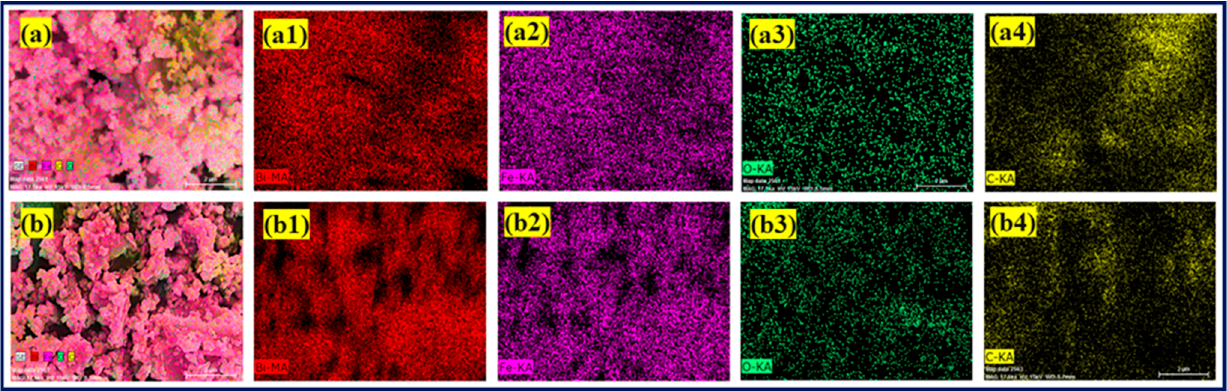
Figure 3. The energy dispersive X-ray spectroscopy image of [BiFe 1 − x Li x O 3 ]-graphene nanocompo- site. ( a – a4 ) x = 0.04 and ( b – b4 ) x = 0.06.